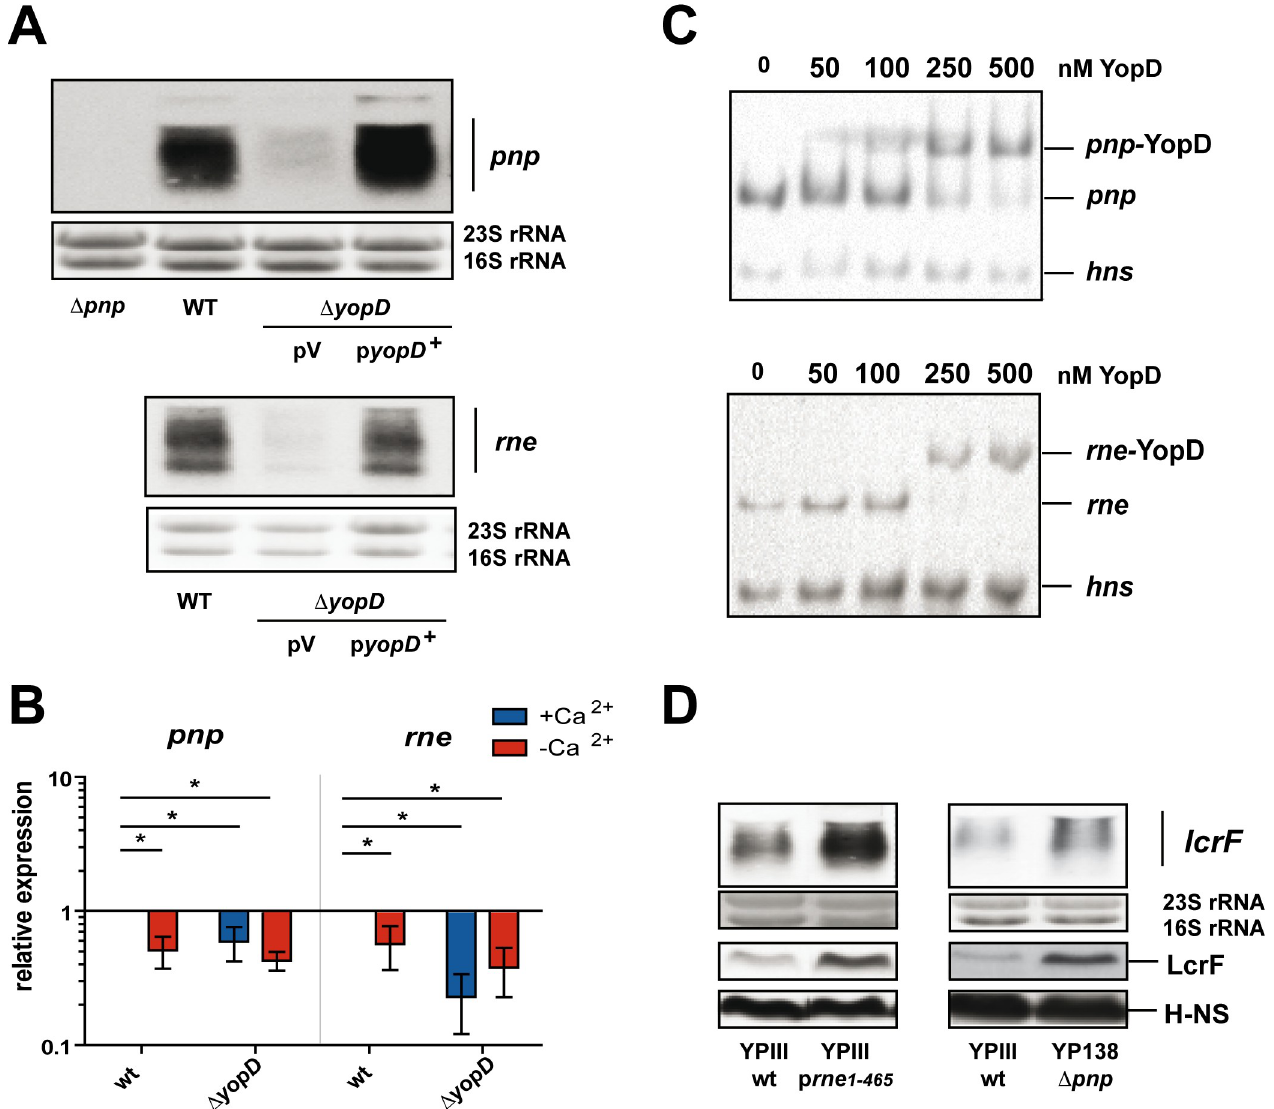
Fig 7. YopD influence on the degradosome RNases PNPase and RNase E. (A) Y . pseudotuberculosis strain YPIII (WT), YP91 ( Δ yopD ) pRS1 (empty vector), YP91 ( Δ yopD ) pRS2 ( yopD + ) and YP138 ( Δ pnp ) were grown at 37˚C. Total RNA of the cultures was prepared and subjected to northern blotting using a pnp (upper panel) or rne (lower panel) specific probe. Total RNA of YP138 ( Δ pnp ) was used as negative control, and the 16S and 23S rRNAs served as loading controls. A representative of at least three independent experiments is presented. (B) Y . pseudotuberculosis strain YPIII (WT) and YP91 ( Δ yopD ) were grown at 37˚C in the presence (+Ca 2+ , non-secretion conditions) or absence (-Ca 2+ , secretion conditions) of 20 mM MgCl 2 and 20 mM sodium oxalate. Total RNA was prepared and a real-time qRT-PCR analysis was performed with specific primers for the pnp and rne transcripts. Transcript levels were normalized to the sopB reference transcript and are shown as relative expression to the wildtype (YPIII) under non-secretion (+Ca 2+ ) conditions. Relative expression data of both mRNAs show the mean ± SD from at least three independent replicates and were analyzed with a one sample t-test with P-value: � : P < 0,05. (C) The in vitro generated pnp (upper panel), rne (lower panel) and hns transcripts were incubated with increasing amounts of purified YopD. The pnp- and rne -YopD complexes are indicated. (D) Y . pseudotuberculosis strain YPIII (WT), YPIII p rne 1-465 expressing a dominant negative rne variant (pRS40) and YP138 ( Δ pnp ) were grown at 37˚C. Total RNA of the cultures was prepared and subjected to northern blotting using an lcrF specific probe. The 16S and 23S rRNAs served as loading controls. In parallel, whole cell extracts of the cultures were prepared and western blot analysis using a polyclonal antibody directed against LcrF and H-NS (control) was